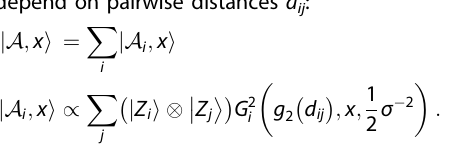
Fig. 3 Many-body tensor representation. Shown are broadened distances (no weighting) arranged by element combination.